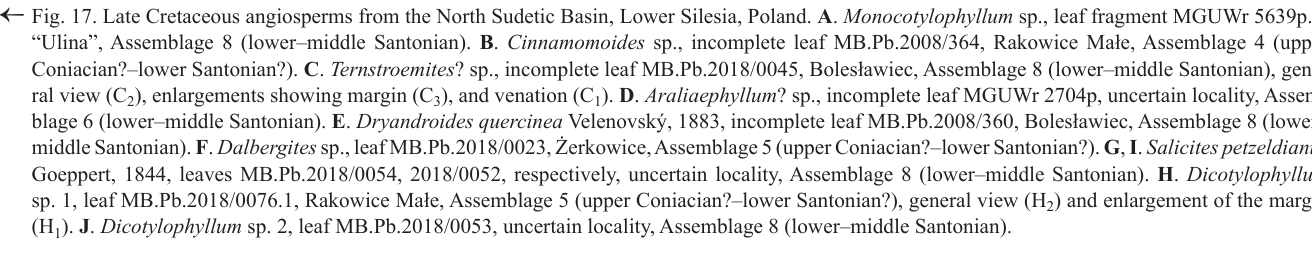
Fig. 17. Late Cretaceous angiosperms from the North Sudetic Basin, Lower Silesia, Poland. A . Monocotylophyllum sp., leaf fragment MGUWr 5639p.b, “Ulina”, Assemblage 8 (lower–middle Santonian). B . Cinnamomoides sp., incomplete leaf MB.Pb.2008/364, Rakowice Małe, Assemblage 4 (upper Coniacian?–lower Santonian?). C . Ternstroemites ? sp., incomplete leaf MB.Pb.2018/0045, Bolesławiec, Assemblage 8 (lower–middle Santonian), gene- ral view (C 2 ), enlargements showing margin (C 3 ), and vena tion (C 1 ). D . Araliaephyllum ? sp., incomplete leaf MGUWr 2704p, uncertain locality, Assem- blage 6 (lower–middle Santonian). E . Dryandroides quercinea Velenovský, 1883, incomplete leaf MB.Pb.2008/360, Bolesławiec, Assemblage 8 (lower– middle Santonian). F . Dalbergites sp., leaf MB.Pb.2018/0023, Żerkowice, Assemblage 5 (upper Coniacian?–lower Santonian?). G , I . Salicites petzeldianus Goeppert, 1844, leaves MB.Pb.2018/0054, 2018/0052, respectively, uncertain locality, Assemblage 8 (lower–middle Santonian). H .